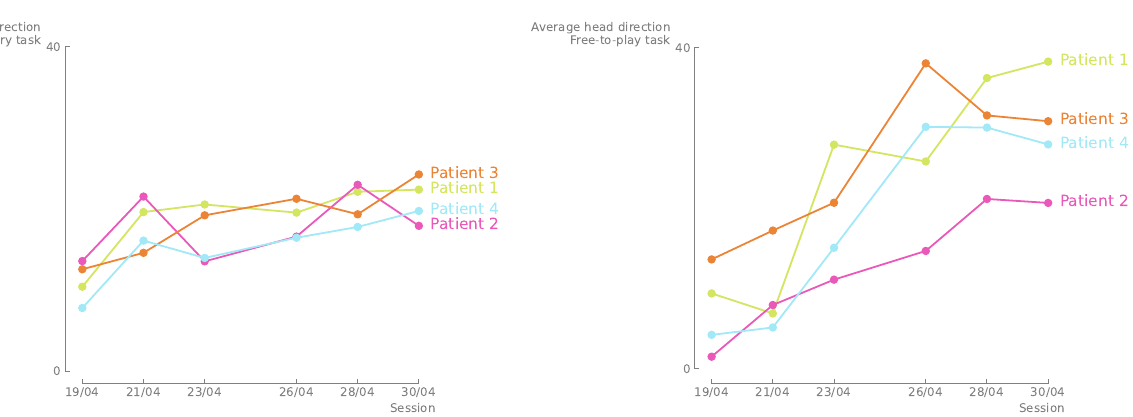
Figure 18. ( Left ) The average head direction for the Memory task for each patient during all 6 sessions indicates a gradually increasing correction towards their neglected side. ( Right ) The average head direction for the Free-to-Play task for each patient during all 6 sessions indicates a gradually increasing correction towards their neglected